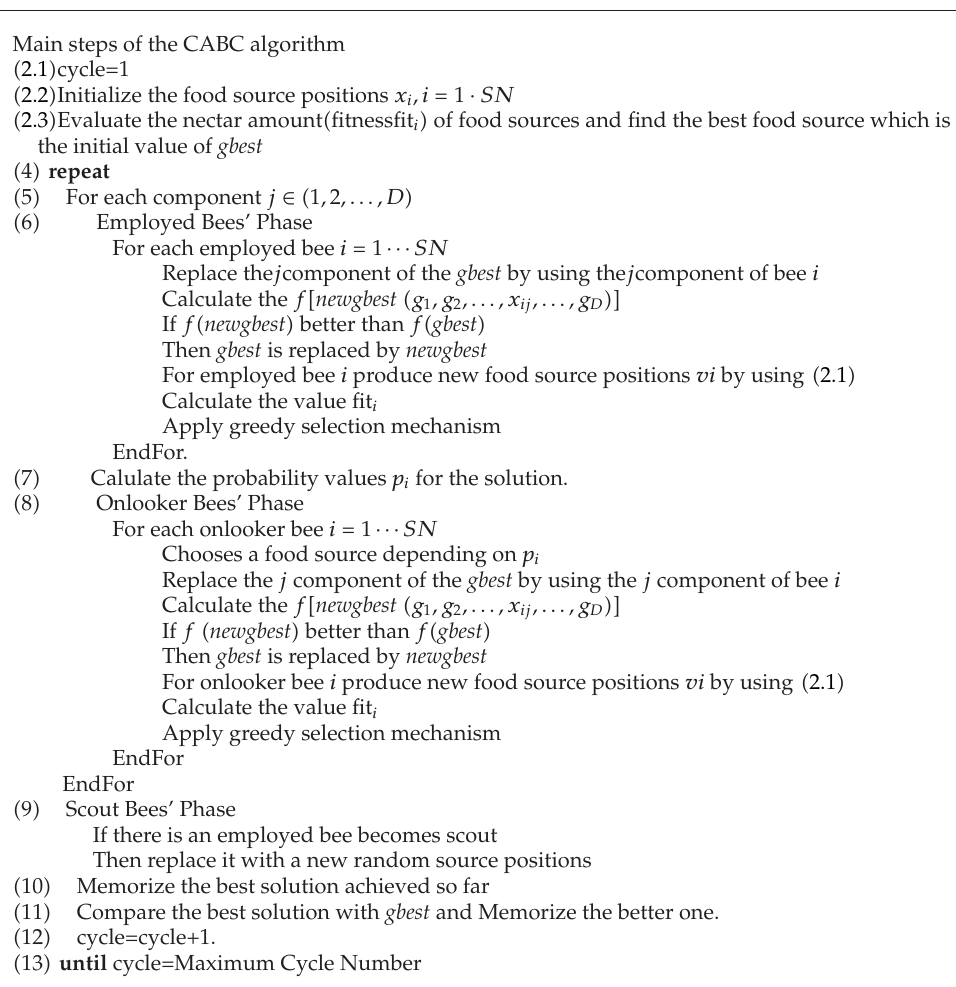
Algorithm 2: Pseudocode for CABC